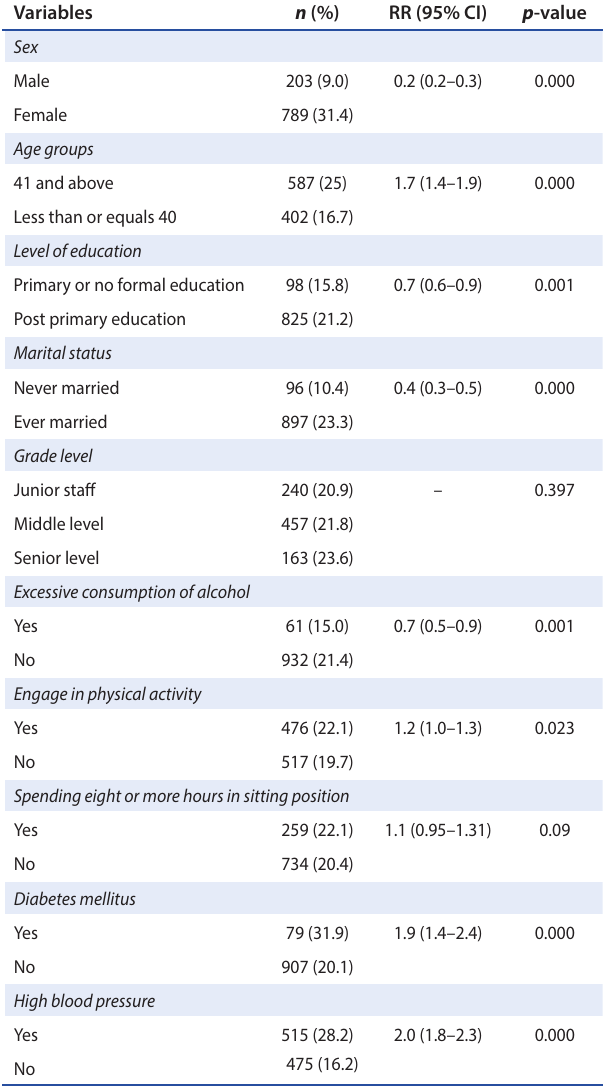
Table 2: Bivariate analysis of the determinants of